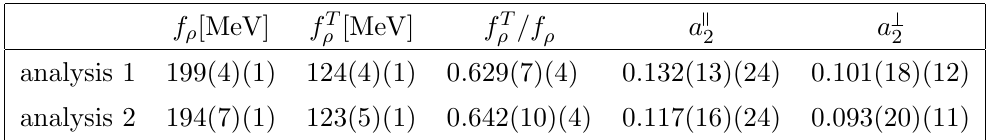
Table 4 . Results in the MS scheme at (cid:22) = 2 GeV from the two analysis methods explained in the main text. The numbers in parentheses denote the statistical error and our estimate of the uncertainty introduced by the renormalization